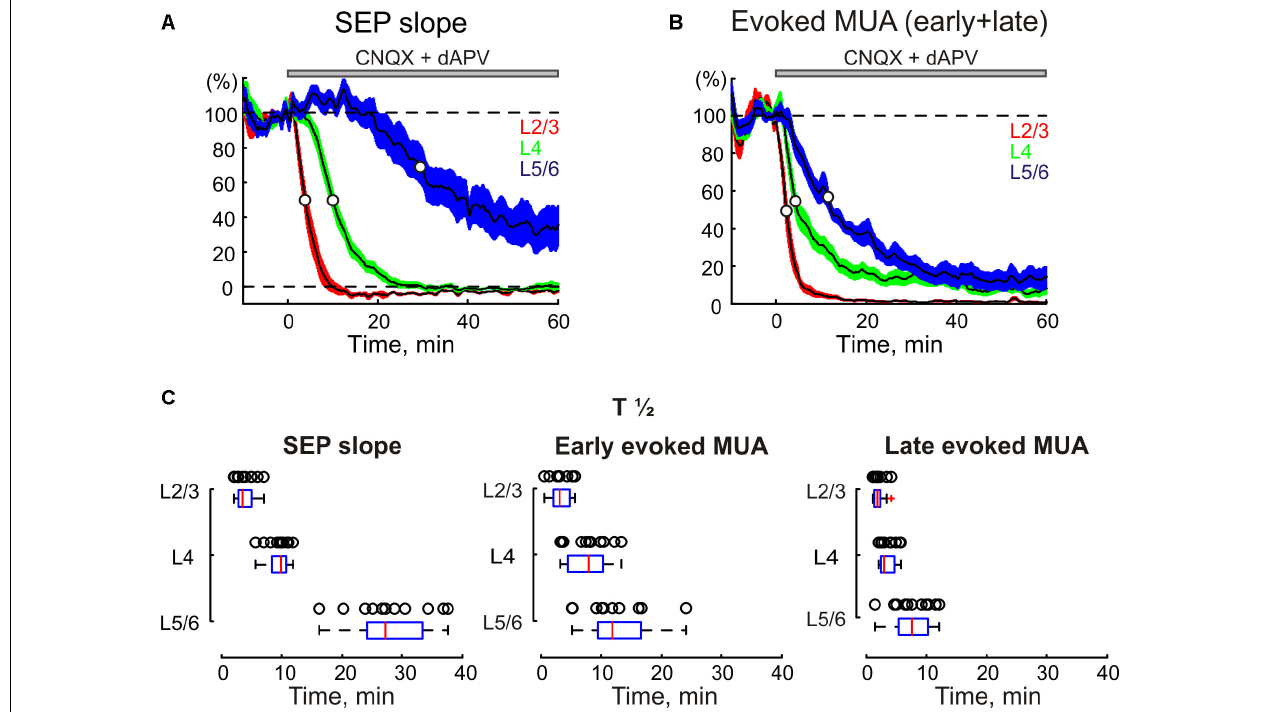
FIGURE 2 | The time course of CNQX and dAPV effect on sensory evoked responses through the depth of the barrel cortex. The decrease in SEP slope (A) and MUA during SEP (B) in different layers of cortical barrel column following application of CNQX and dAPV. The application time is shown with a gray bar above the plot. White circles on the curves indicate a half-maximal effect time (T 1 / 2 ). The colored areas surrounding each curve show SE bands. (C) Statistical data on T 1 / 2 of CNQX and dAPV effect on SEP slope ( left ), early evoked MUA ( middle ) and late evoked MUA ( right ) across cortical layers. The open circles correspond to individual experiments. The medians of boxplots are shown by red lines. (A–C) , pooled data from 11 animals and two concentrations, 170 µ M CNQX/700 µ M dAPV and 0.5 mM CNQX/2 mM